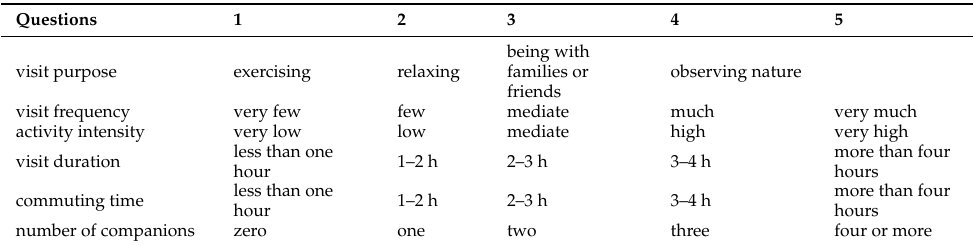
Table 1. Questions on visiting characteristics of forest park and items.